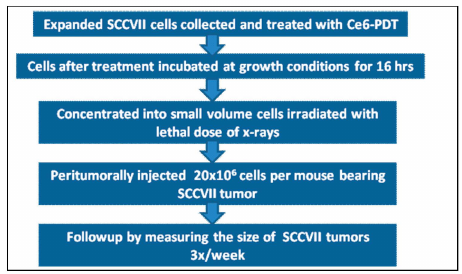
Figure 8. Schematic representation of PDT vaccine preparation.